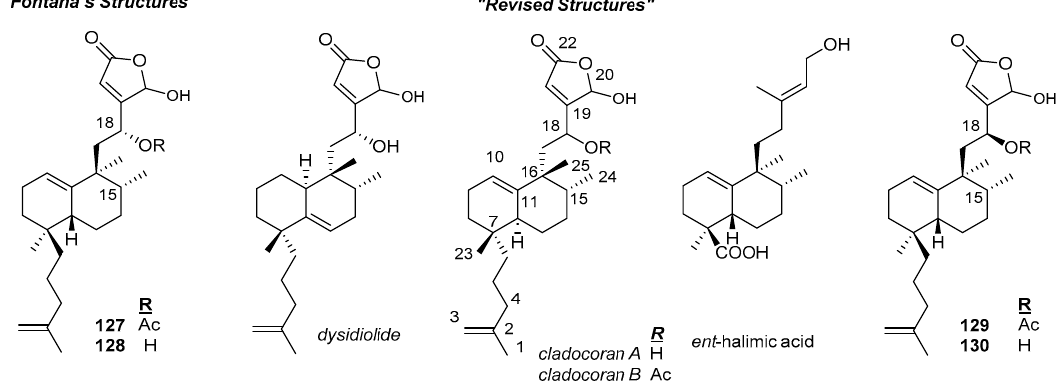
Figure 7. Chemical structures for sesterterpenolides and ent -halimic acid.